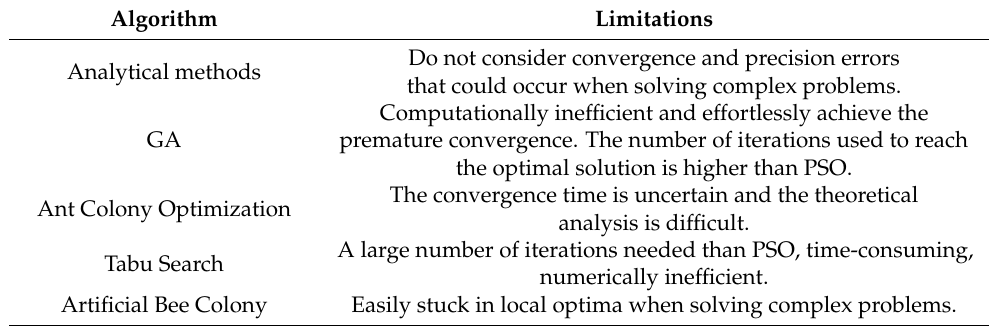
Table 1. Limitations of different algorithms used for optimal sizing of distributed generators